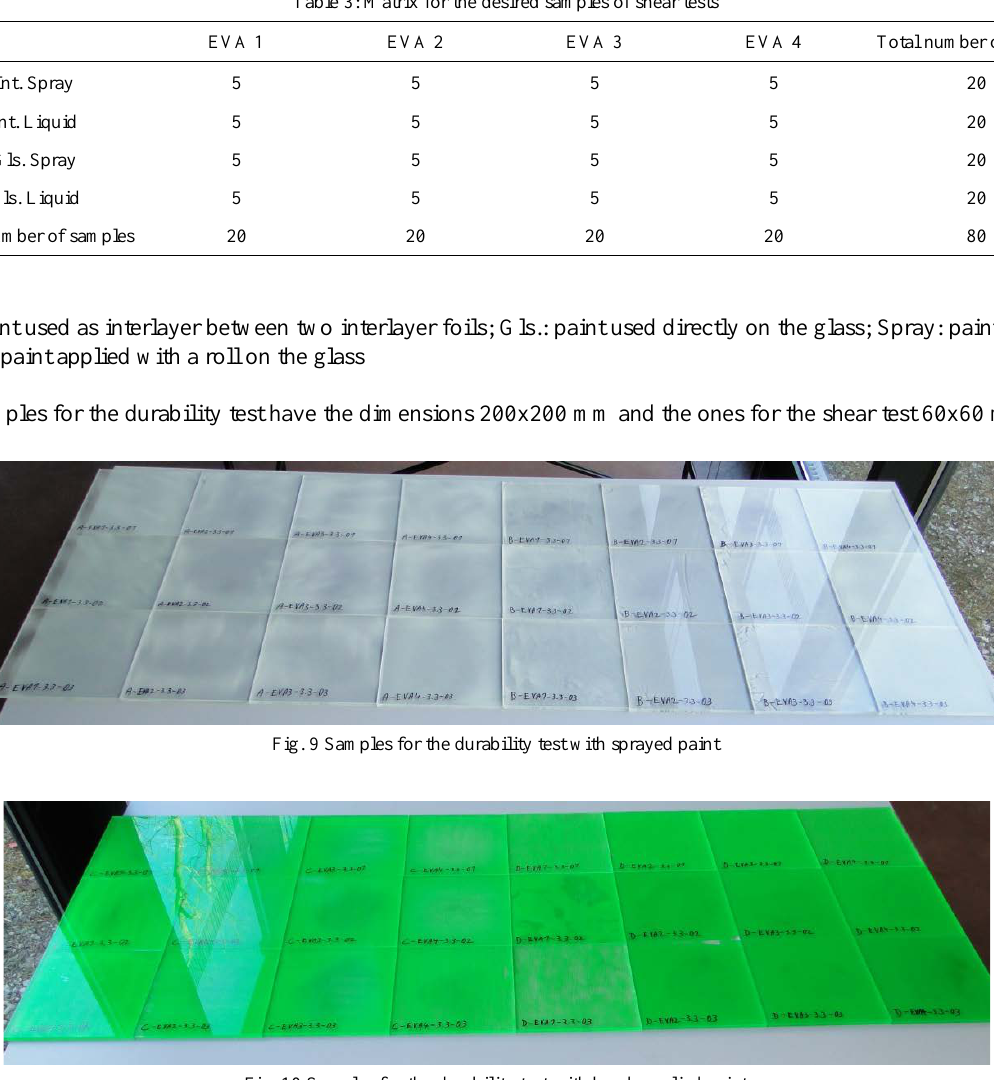
Fig. 10 Samples for the durability test with brush applied